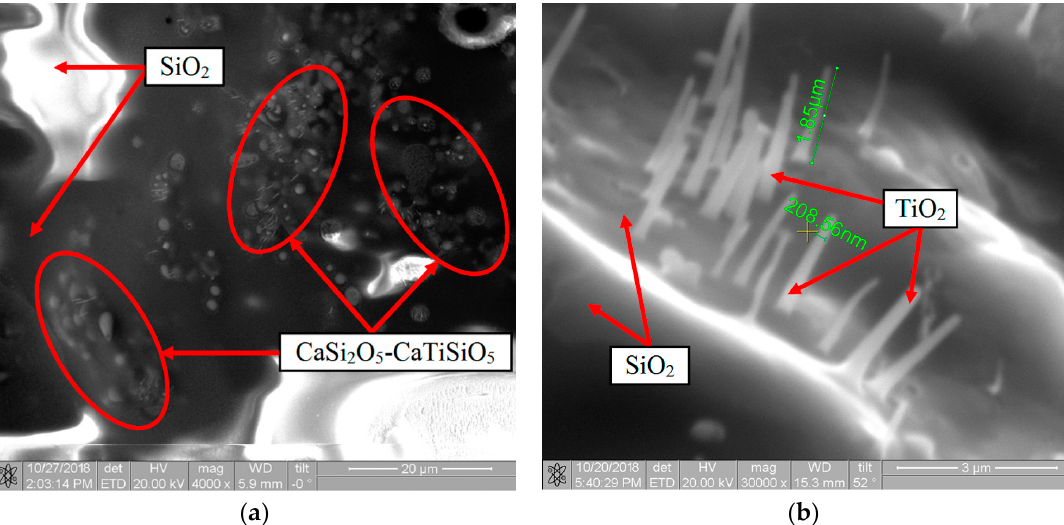
( b ) Figure 11. The microstructure of the cross section of the coating containing in situ-formed Si 2 ON 2 fibers after gas-dynamic tests according to the regime shown in Figure 7 а : ( а ) х 2850; ( b ) х 8000. Structural studies of the oxide film from the surface of the samples revealed the presence of the effect of high-temperature phase separation and confirmed the assump- tion of an increase in the degree of heterogeneity as a result of doping with calcium. The SEM and EDS results, partially shown in Figure 12, showed that the heterogeneous structure of the film was represented mainly by borosilicate glass, thin TiO 2 needles ori-